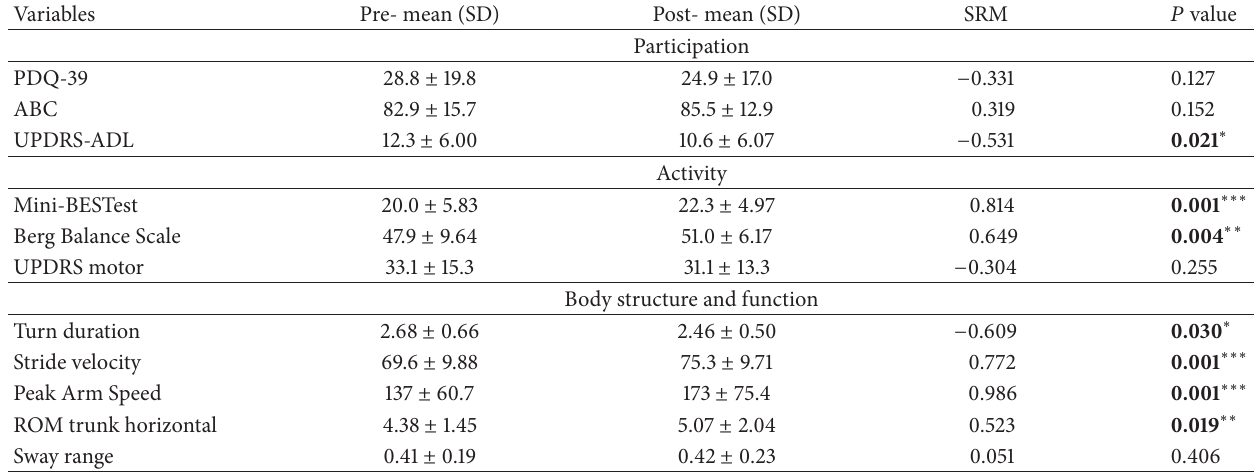
Table 3: The effects of exercise intervention for each category of ICF.